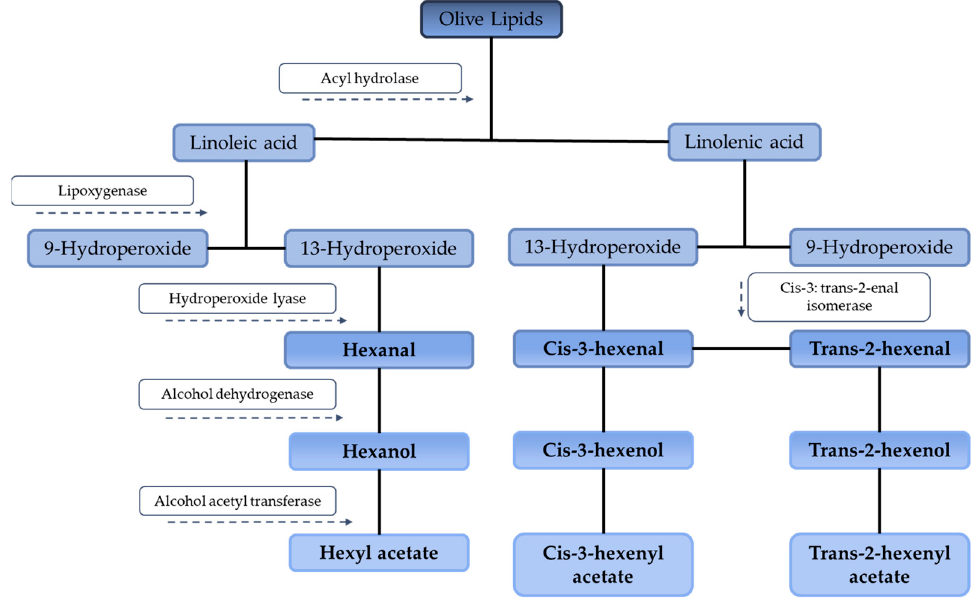
Figure 3. Pathways for the formation of the principal volatile compounds present in extra virgin olive oils (EVOOs).